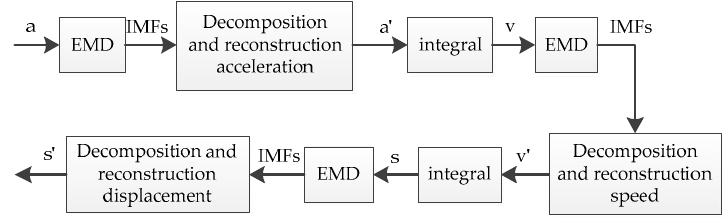
Figure 4. Flow field based on EMD adaptive filtering process.